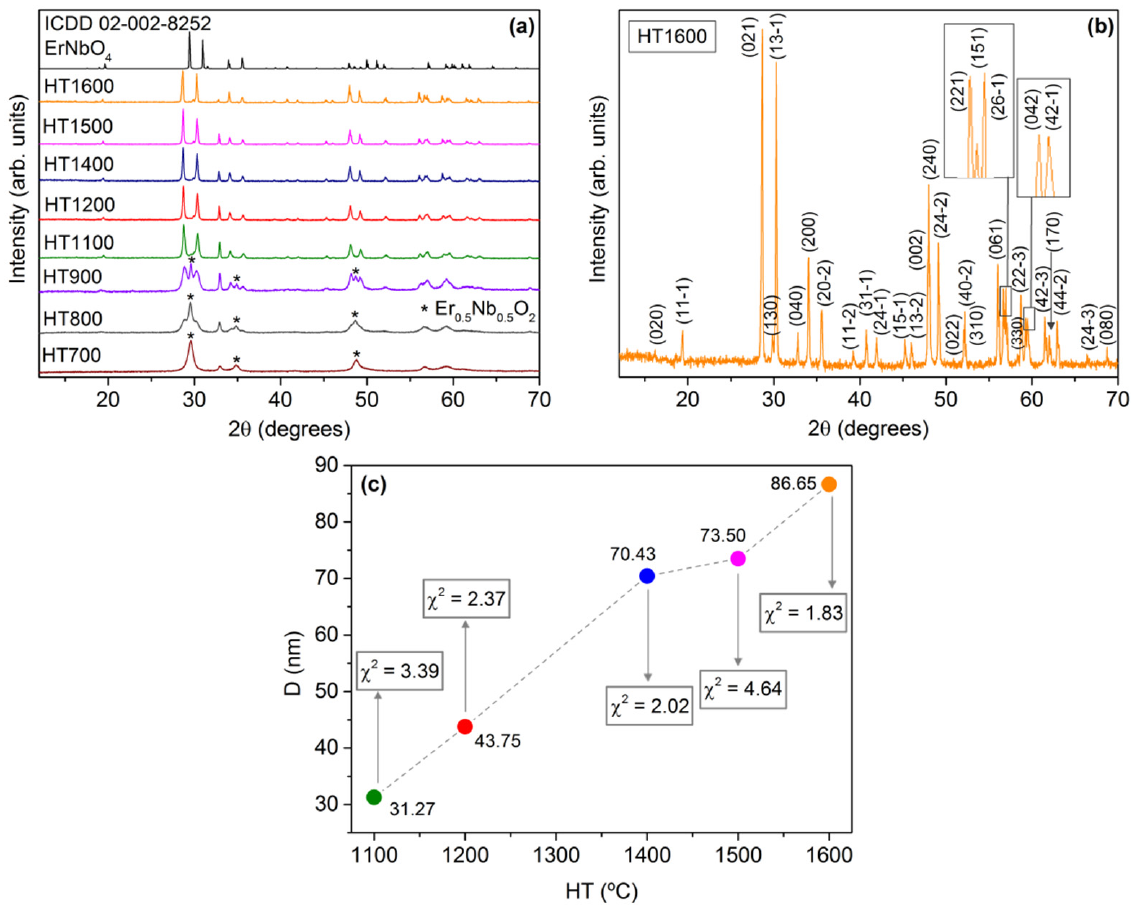
Figure 2. ( a ) X-ray diffraction patterns of the prepared samples; ( b ) measured diffractogram of the sample heat-treated at 1600 °C and Miller indexed planes; ( c ) crystallite size of the samples with pure ErNbO 4 , as a function of heat treatment temperature, estimated through the Rietveld analysis.